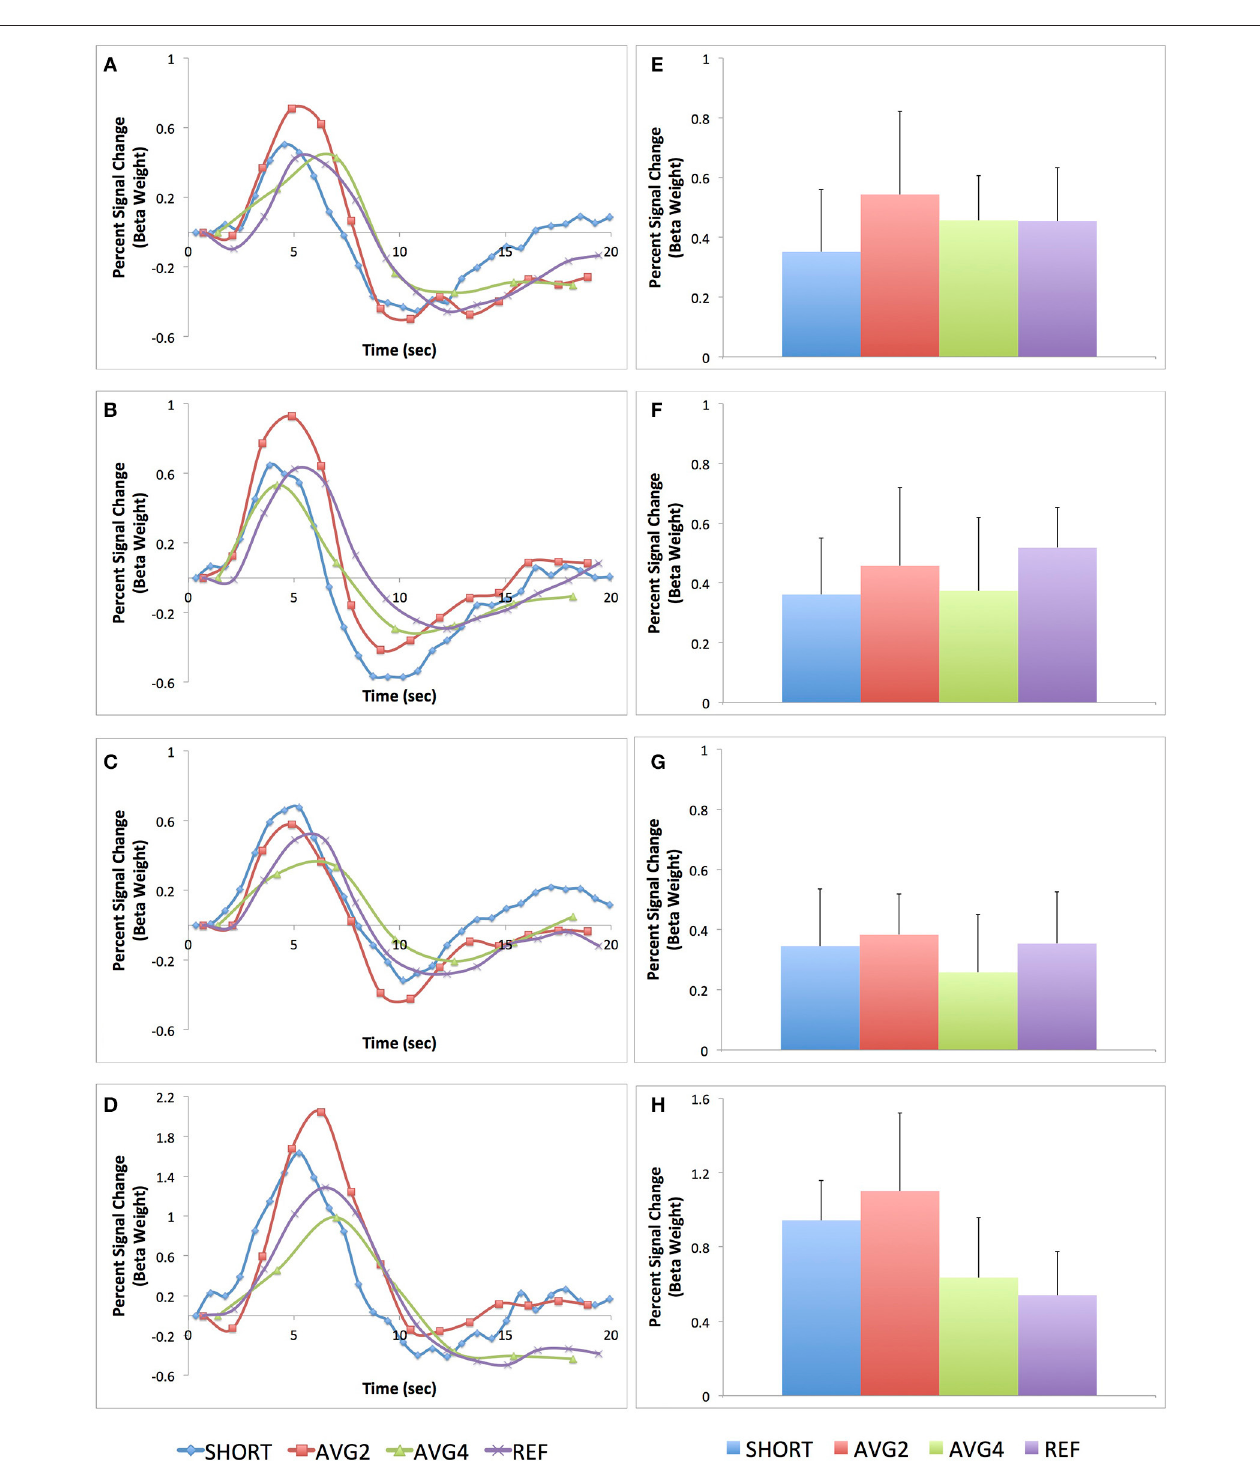
FIGURE 5 | Peri-stimulus histogram timing curves and average percent signal change for each of the four EPI sequences for four task-related regions-of-interest. (A) PSTH curve for anterior cingulate cortex; (B) PSTH curve for supplementary motor area; (C) PSTH curve for left primary motor cortex; (D) PSTH curve for medial primary visual cortex; (E) Average percent signal change for anterior cingulate cortex; (F) Average percent signal change for supplementary motor area; (G) Average percent signal change for left primary motor cortex; (H) Average percent signal change for medial primary visual cortex. Both the curves and average percent signal change values are plotted in terms of percent signal change of the beta weight. Data from the SHORT sequence (TR = 700 ms) are plotted in blue, AVG2 sequence (TR effective = 1400 ms) in red, AVG4 sequence (TR effective = 2800 ms) in green, and REF sequence (TR = 1400 ms) in purple.